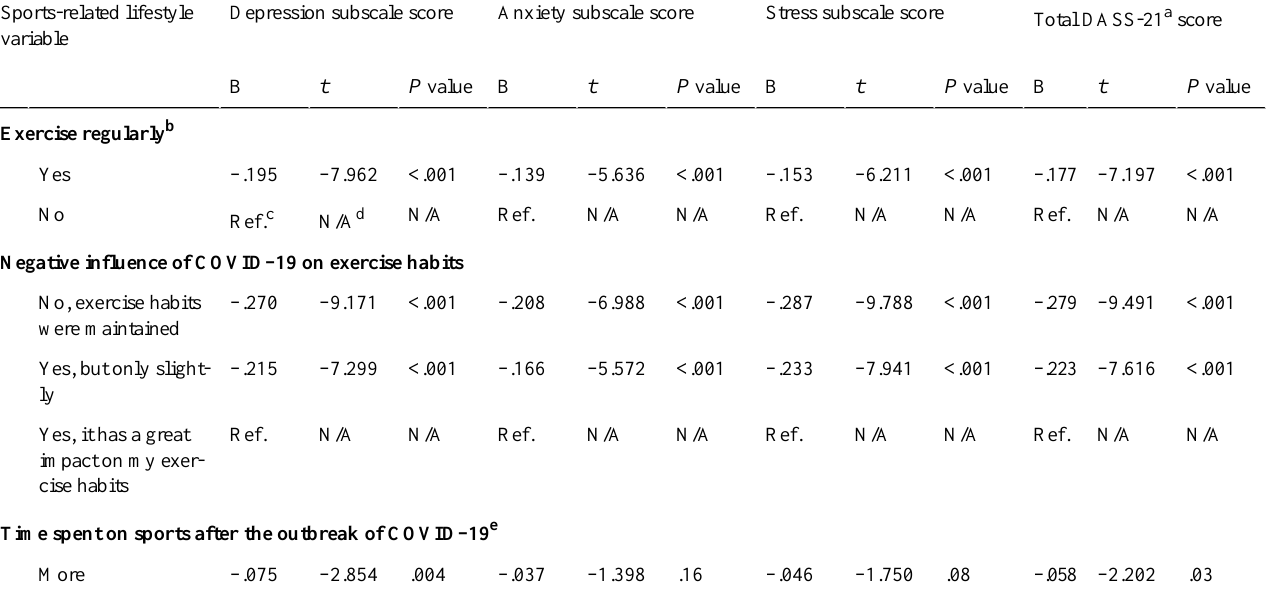
Table 4. Associations between sports-related lifestyle variables and scores on the DASS-21 and its subscales (N=1607).